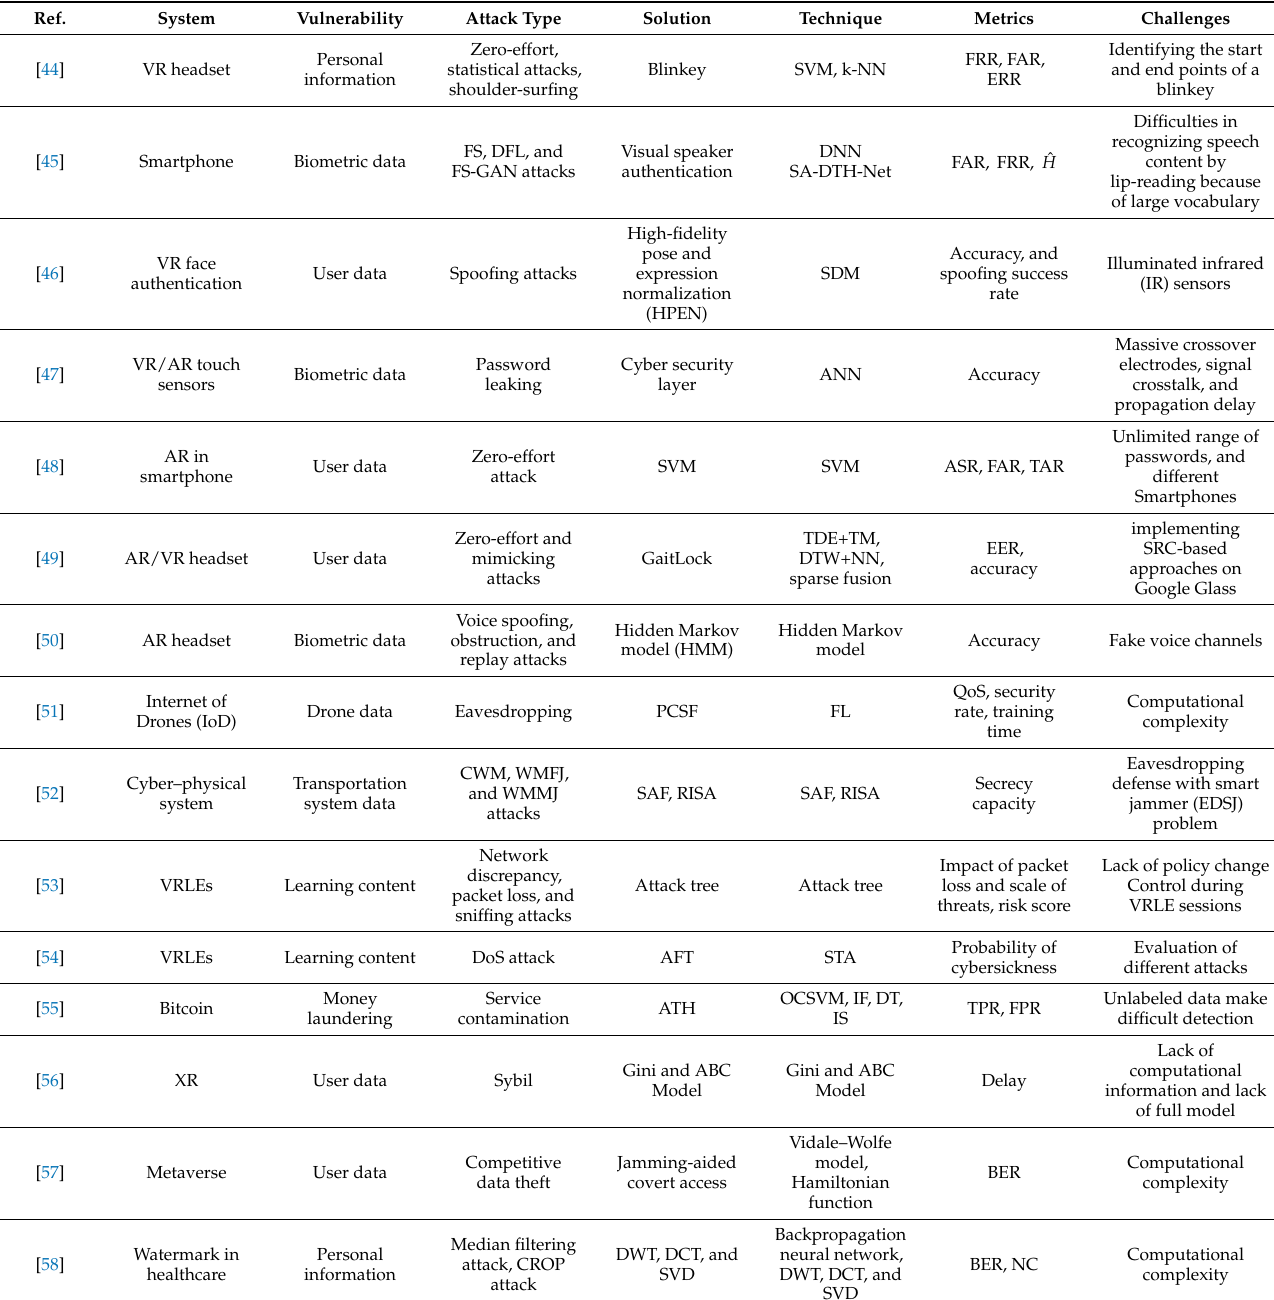
Table 1. AI-based Metaverse cyber security